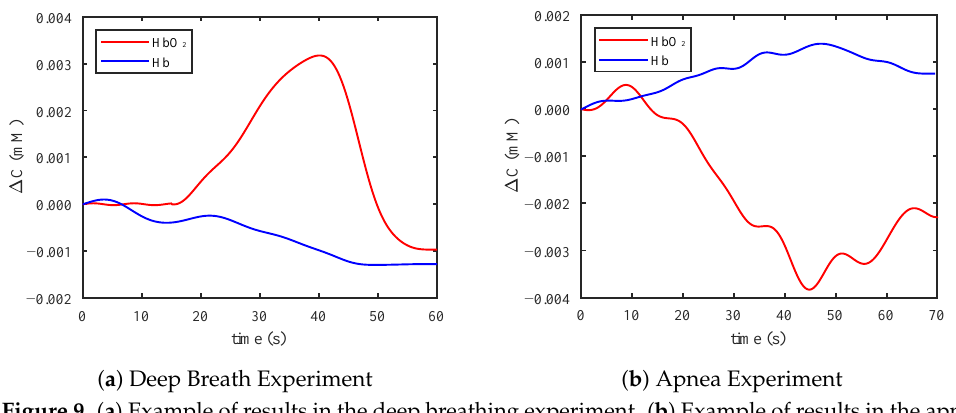
Figure 9. ( a ) Example of results in the deep breathing experiment. ( b ) Example of results in the apnea